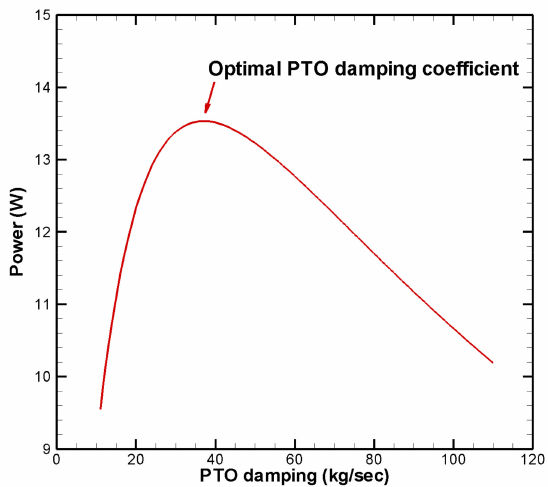
Figure 3. Time-mean extracted power according to the PTO damping coefficient.